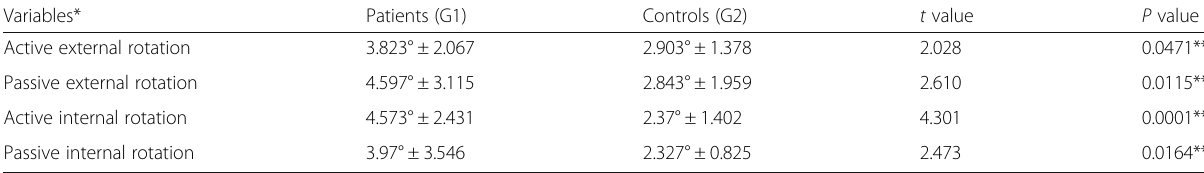
Table 3 Comparison of angular displacement errors of shoulder joint position sense in the affected arm of patients (G1) and dominant arm of normal subject (G2)